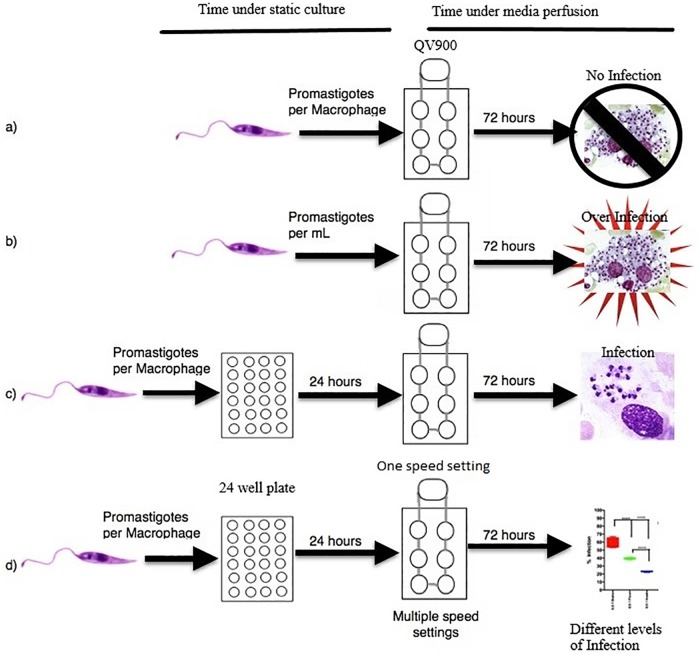
Schematic overview of the initial infection experiments.